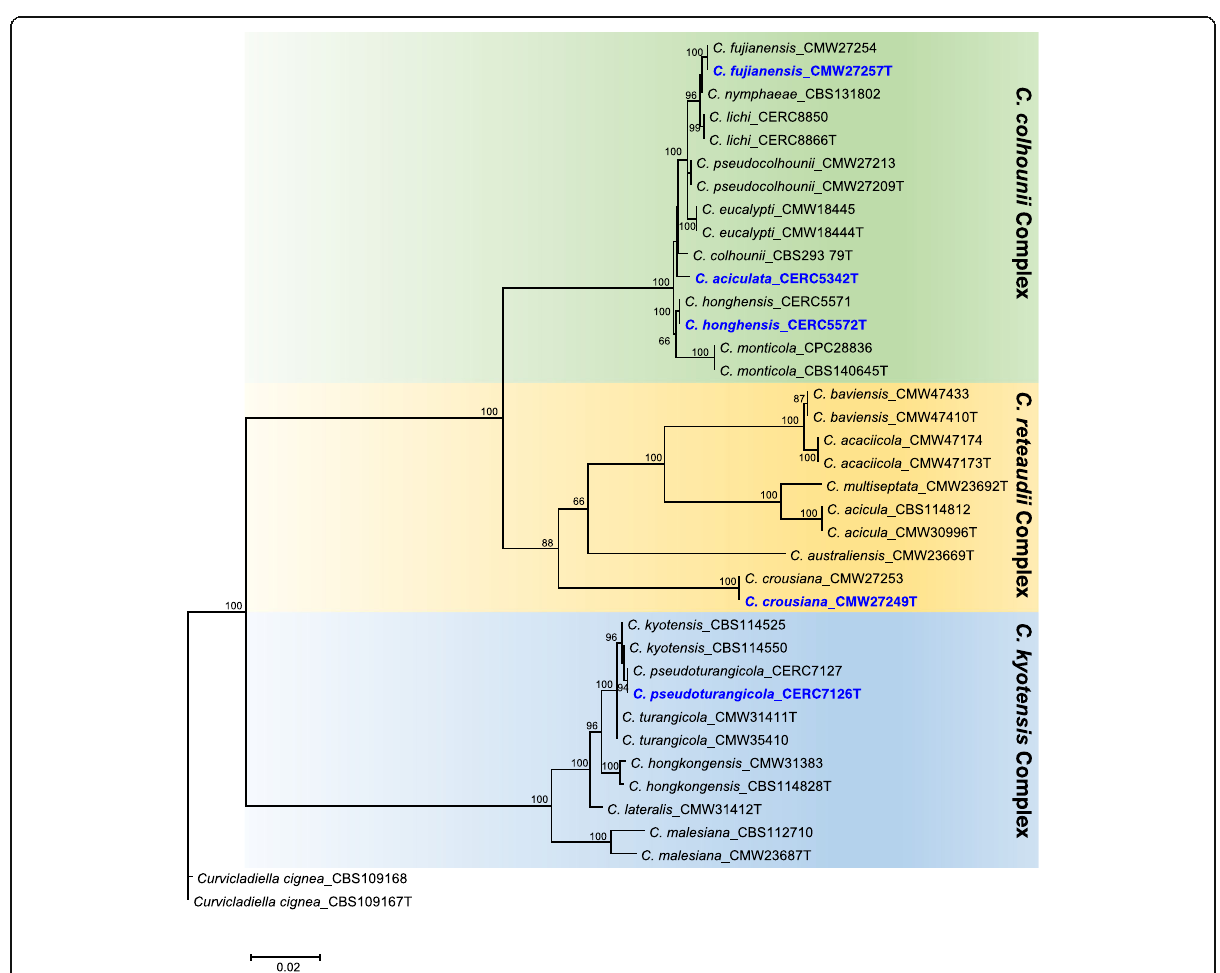
Fig. 1 Maximum likelihood tree based on partial gene sequences of cmdA , his3 , tef1 and but2 gene sequences (Chen et al. 2011b; Li et al. 2017; Liu and Chen 2017; Pham et al. 2019). Bootstrap values ≥ 65% are shown. The isolates used in this study are indicated in blue and